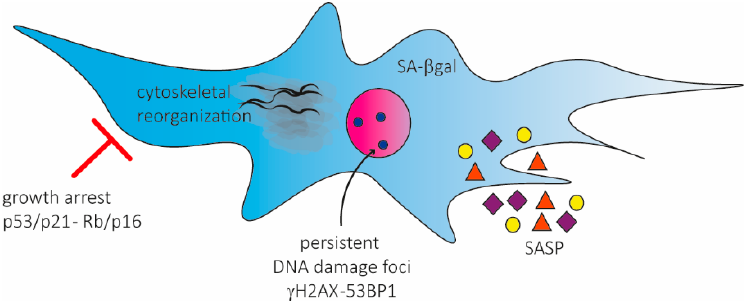
Figure 1. Phenotypic characterization of senescent hMSCs. Senescent hMSCs activate p53/p21 and Rb/p16 pathways to block the cell cycle and sustain growth arrest. Senescent hMSCs are characterized by a specific SASP and by the presence of persistent DNA damage foci, containing γ H2AX and 53BP1, and are positive for SA- β -gal.